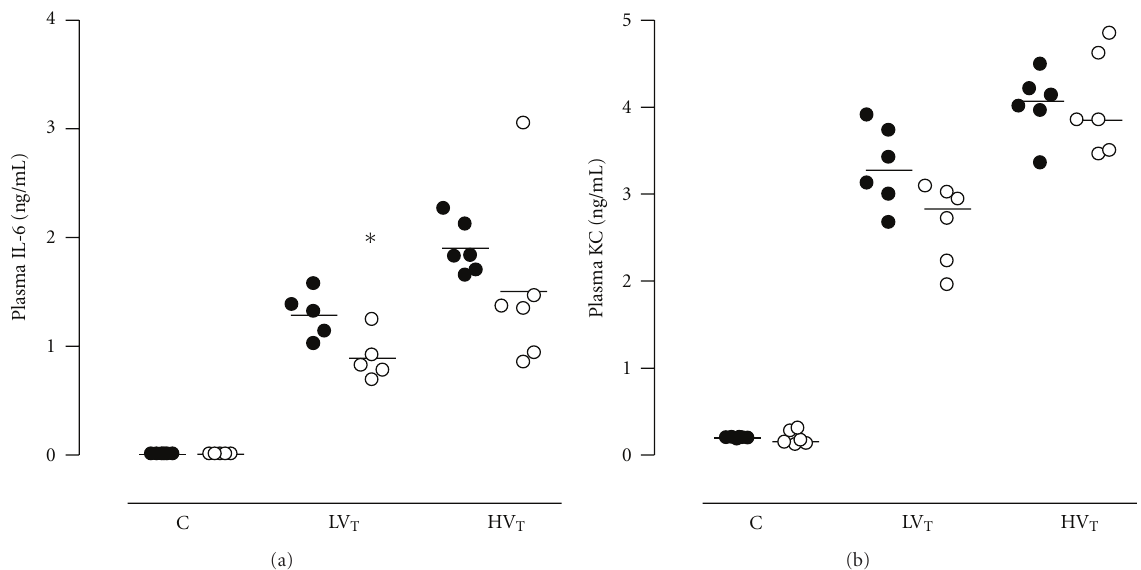
Figure 5: Systemic levels of interleukin- (IL-) 6, and keratinocyte-derived chemokine (KC) in plasma in anesthetized nonventilated control (C) mice, mice ventilated with LV T or HV T . Mice were either PAI-1 deficient (PAI-1 − / − , open symbols) or wild type (Wt, closed symbols). Data are represented as individual data with a median. ∗ indicates statistical significant di ff erence compared to